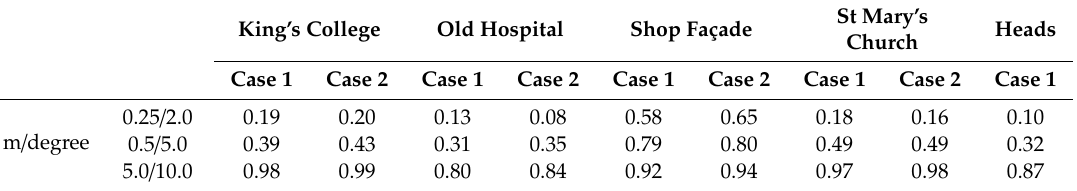
Table 6. Evaluation of the localization rate within a given camera pose error threshold. King’s College Old Hospital Shop